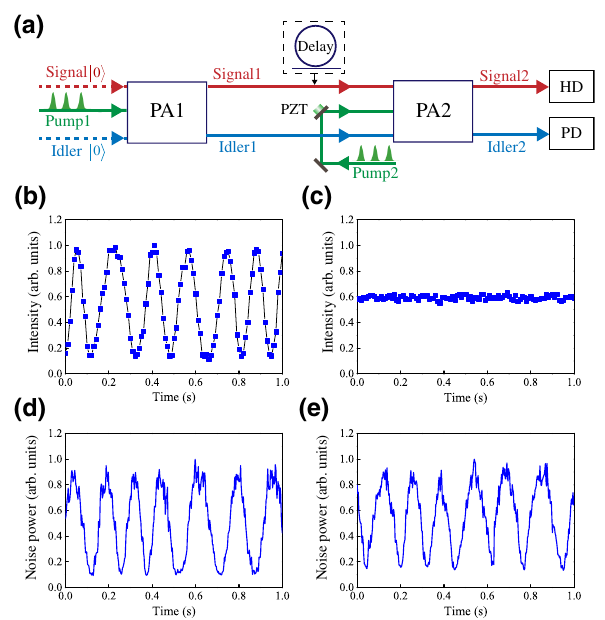
FIG. 1. Observation of quantum interference in an SU(1,1) interferometer. (a) Schematics for the SU(1,1) interferometer (PZT: piezoelectric transducer for phase scan); interference fringes in (b) direct power detection (PD) and (d) homodyne detection (HD) at the output for path-balanced interferometer; (c) disappearance of interference in direct power detection and (e) recovery of interference fringe in homodyne detection for the path-unbalanced